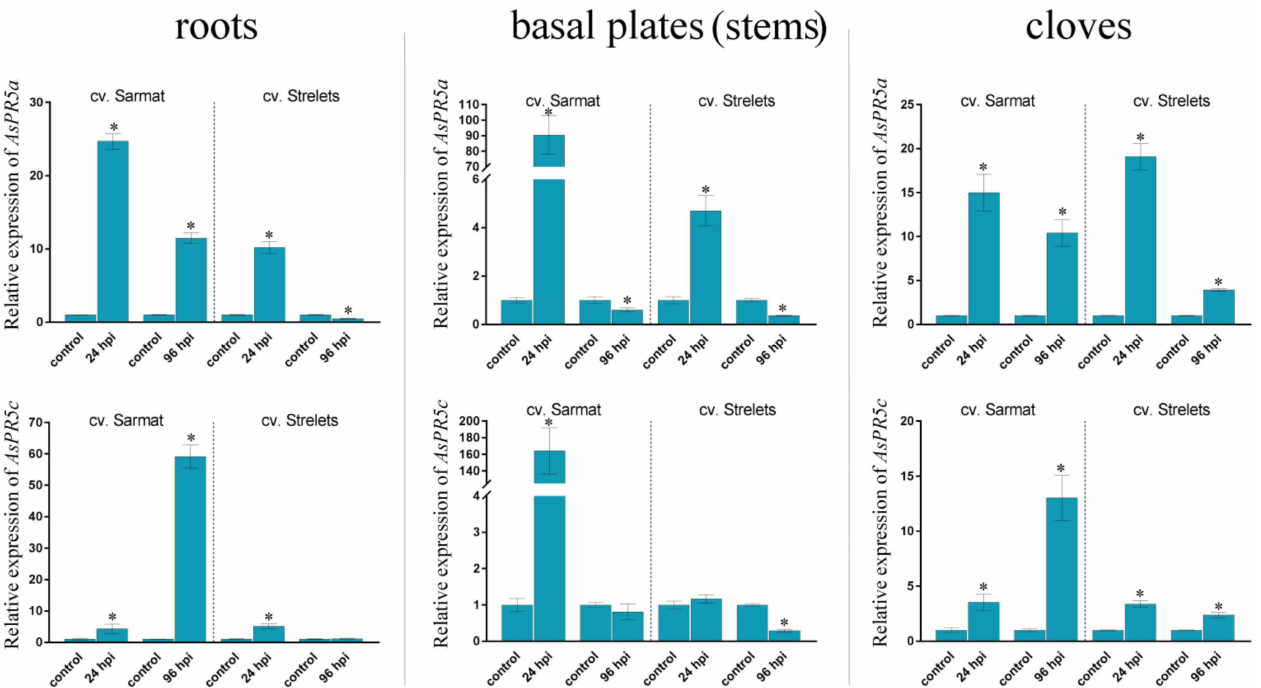
Figure 6. Expression of the AsPR5a , c genes in Allium sativum cv. Sarmat (FBR-resistant) and Strelets (FBR-susceptible) after infection with Fusarium proliferatum . The plants were incubated with F. proliferatum conidia and analyzed for mRNA levels in the roots, stems, and cloves at 24 and 96 hpi by qRT-PCR. The data were normalized to GAPDH and UBQ mRNA levels and presented as fold change (mean ± SE) of the control taken as 1; * p < 0.01 compared to the uninfected